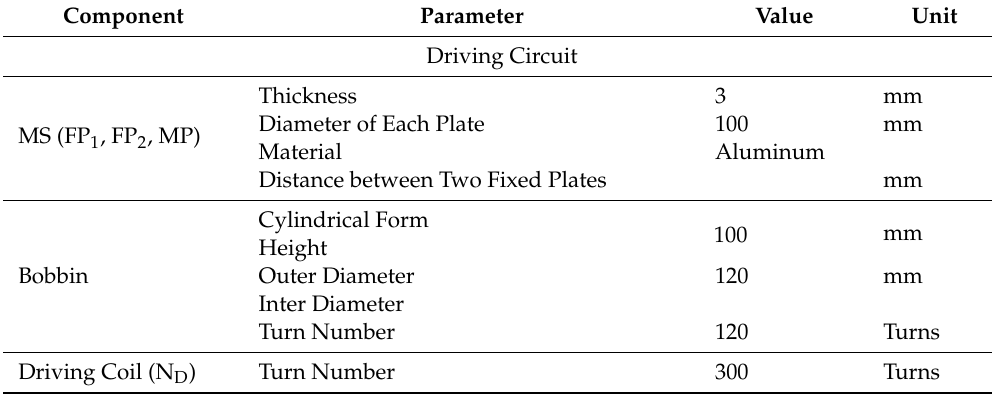
Table A1. Design specification of the superconducting fault current limiting breaker (SFCLB) using flux coupling with a tap